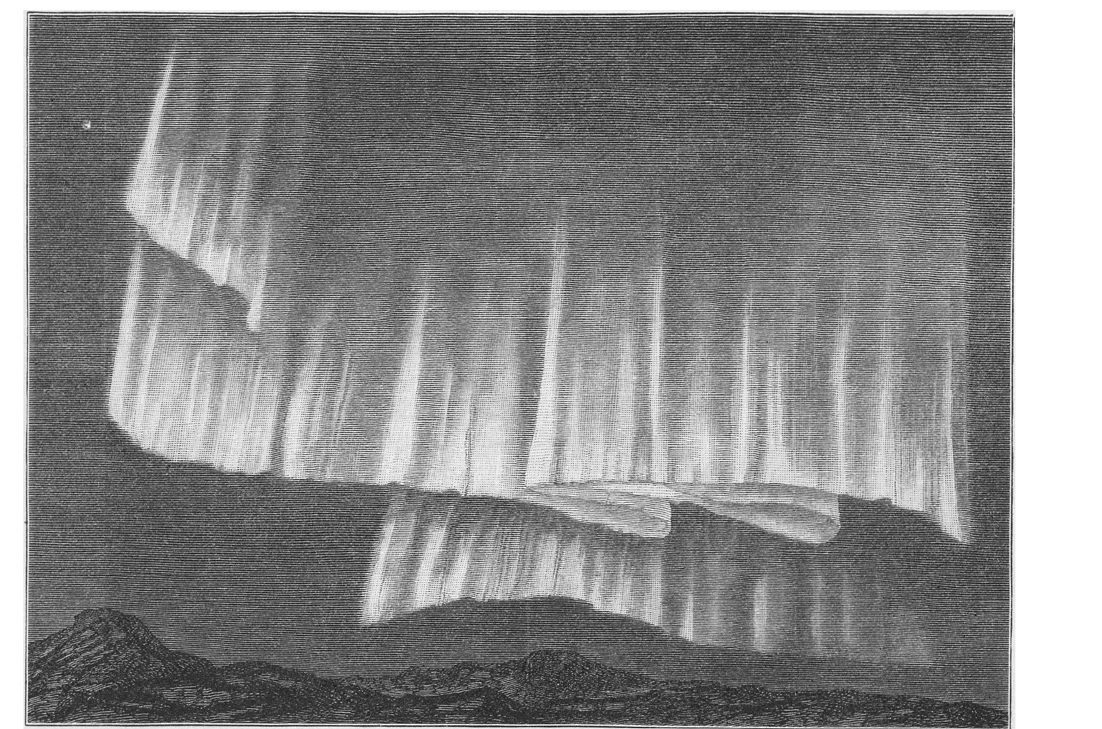
Figure 12. Aurora (folded bands) observed from Godthaab to the South on 15 November 1882 at 00h 10m (drawing, Paulsen, 1893a).